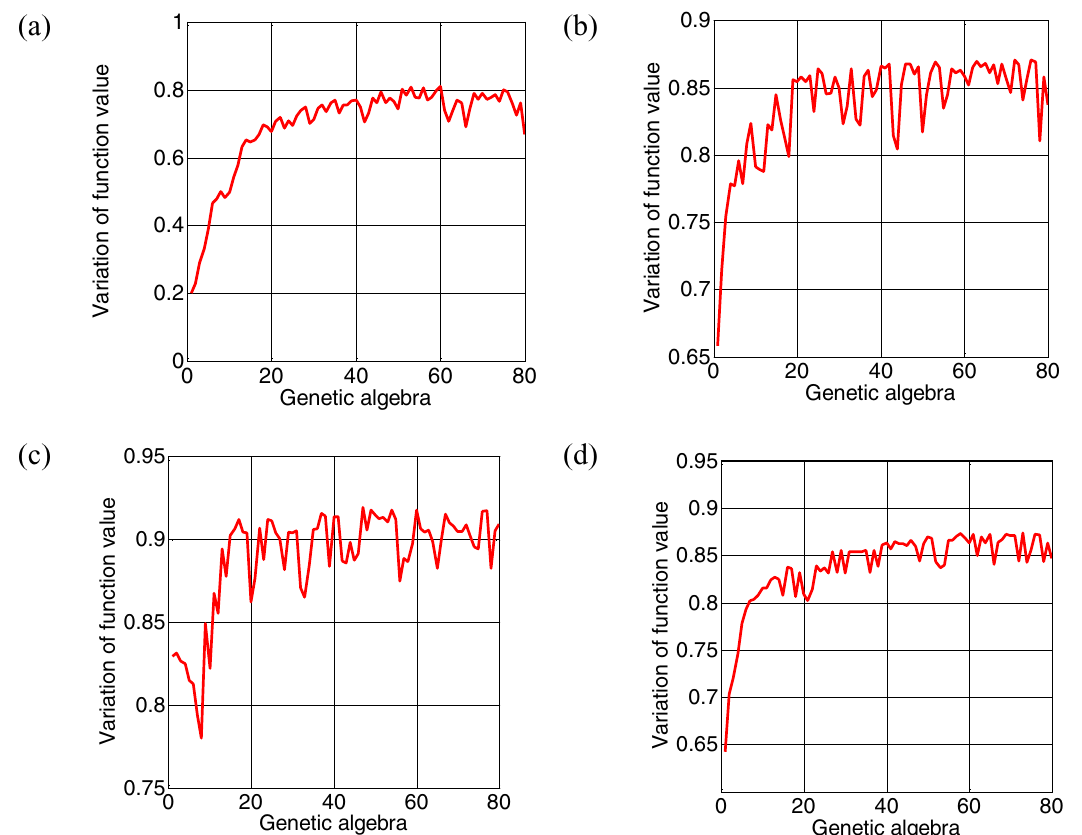
Figure 8: Maximum sound absorption coefficient variation process of PM at different frequency bands and fixed frequency points: (a) in low frequency band, (b) in middle frequency band, (c) in high frequency band, (d) at fixed point